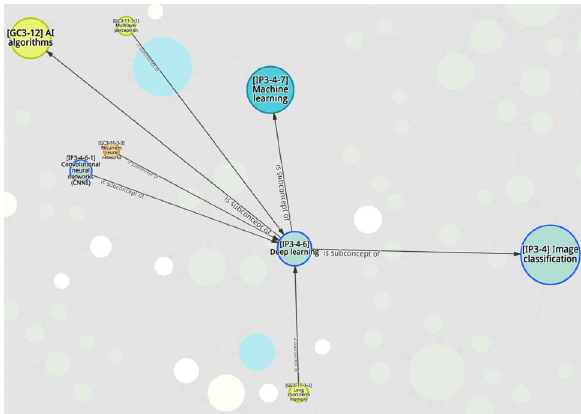
Figure 6 . Direct relationship of Deep learning concept with concepts from AI cluster